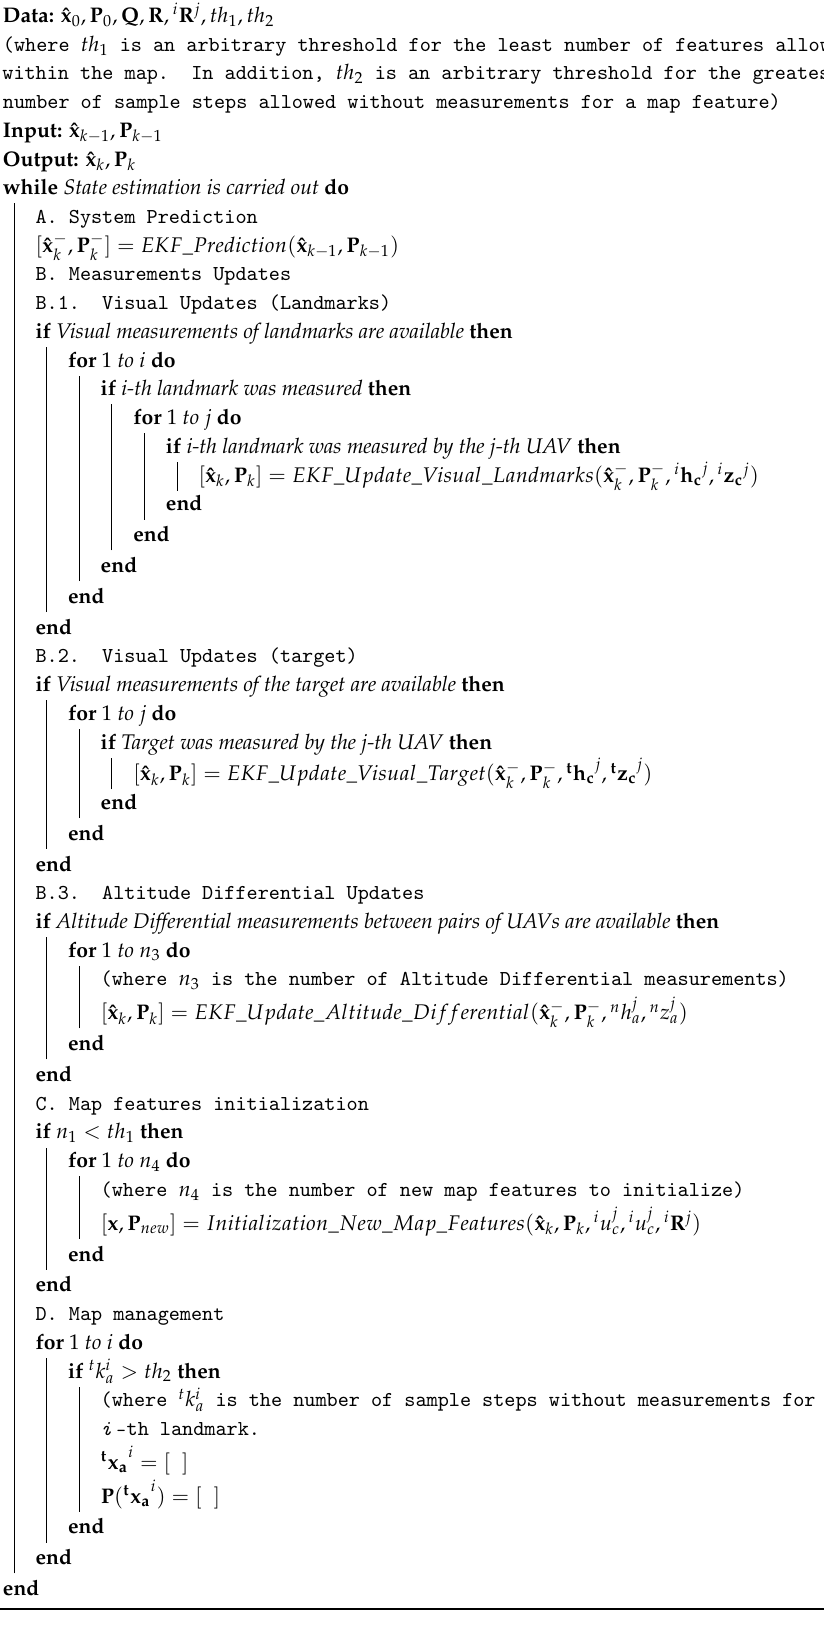
Algorithm 1: EKF-SLAM target-Centric